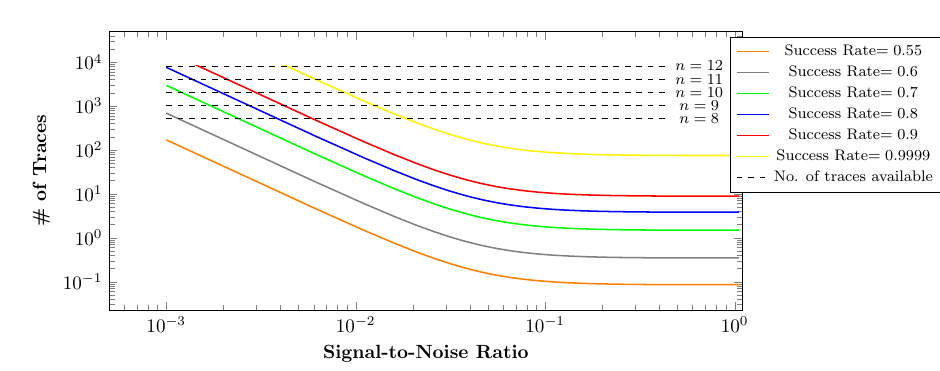
Figure 4: Lower bounds for the # of traces needed to reach di ff erent SR of the improved attack. Dashed black line shows number of encryption blocks that can be observed for each n